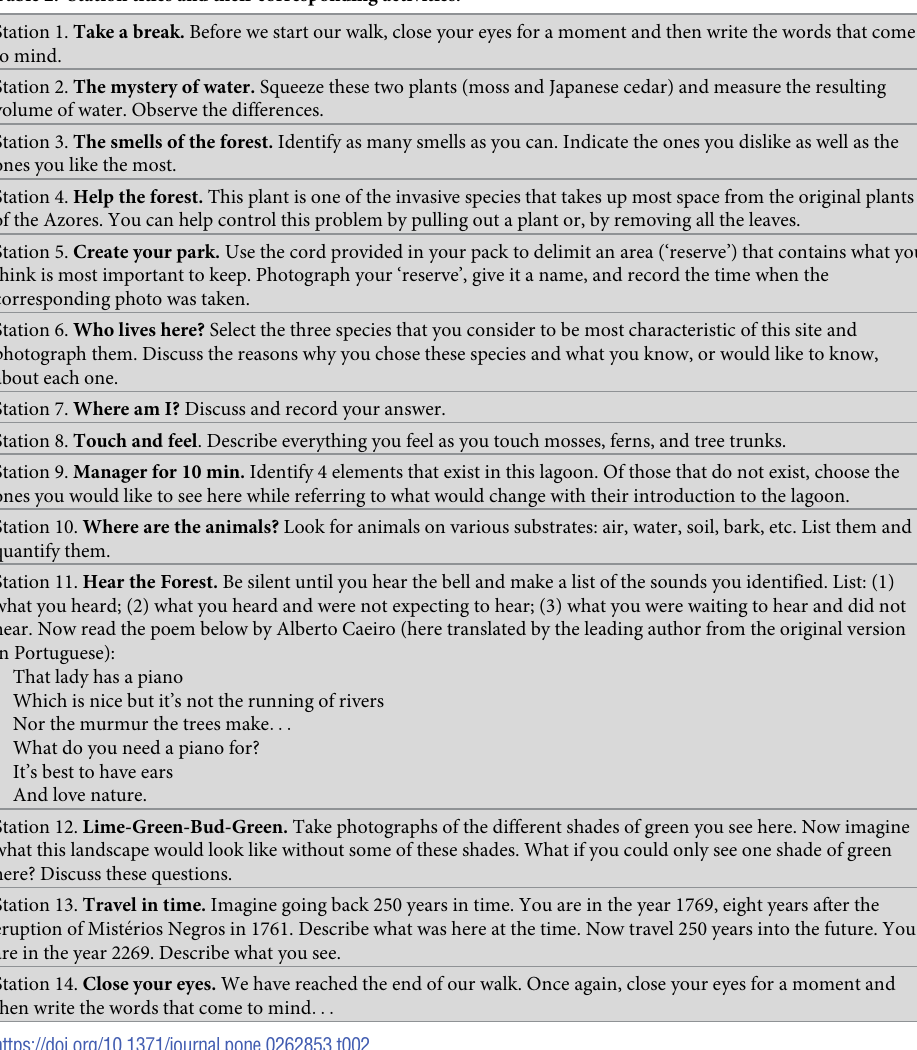
Table 2. Station titles and their corresponding activities.